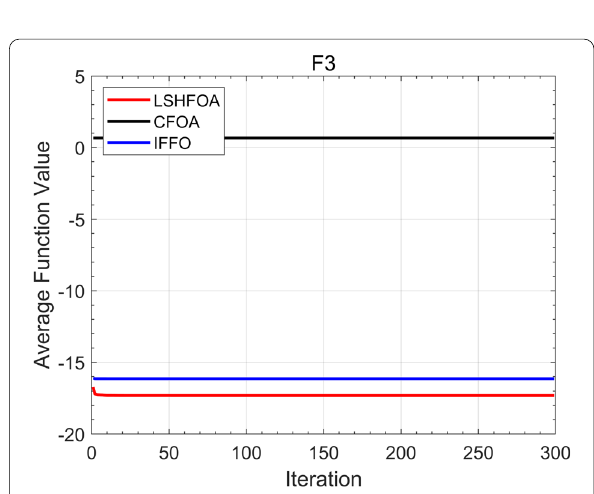
Fig. 9 Performance of the algorithm under F3 function